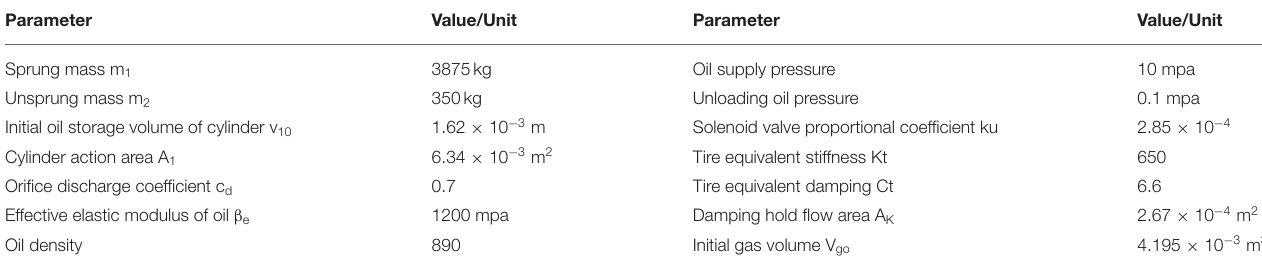
TABLE 1 | The main parameters of the active hydro-pneumatic suspension experimental system.